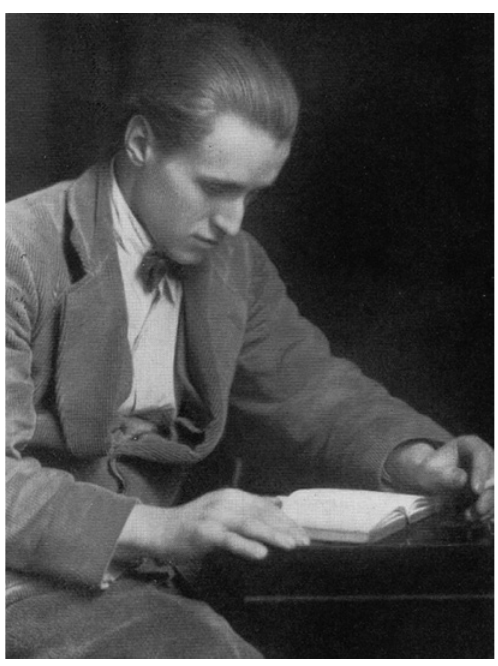
Figure 3. Tommy around the time of his twenty-first birthday (Source: By permission of M.A.B.